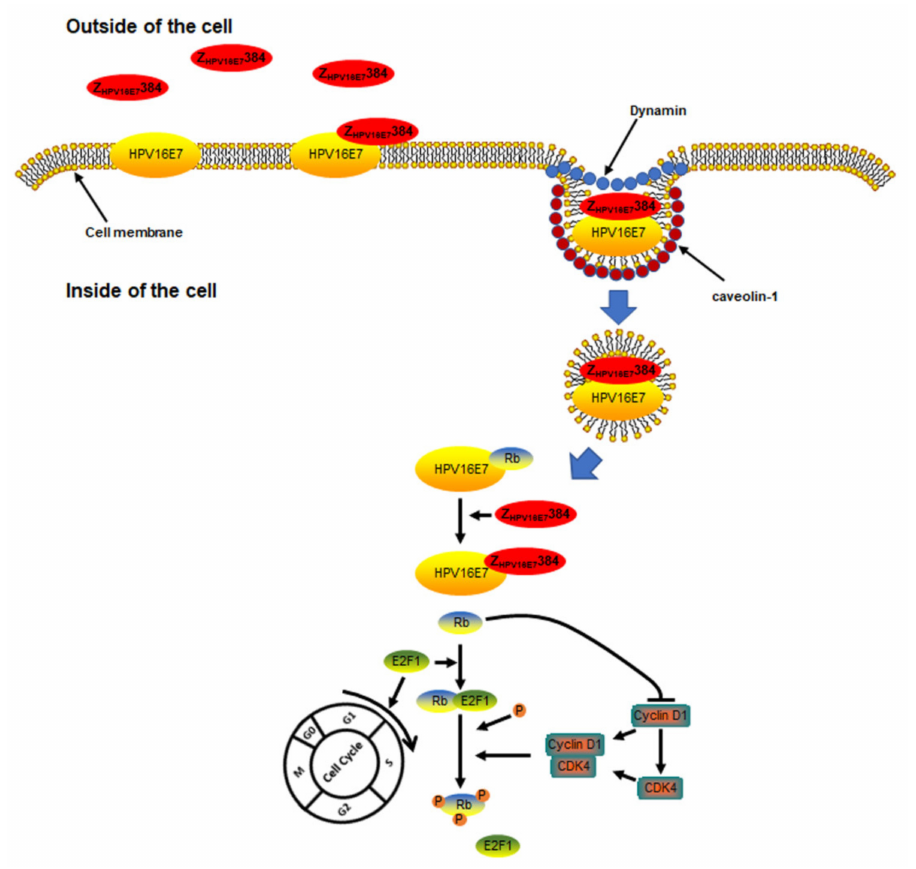
Figure 9. A schematic model to summarize the internalization pathway of Z HPV16E7 384 and its effect on the cell proliferation related